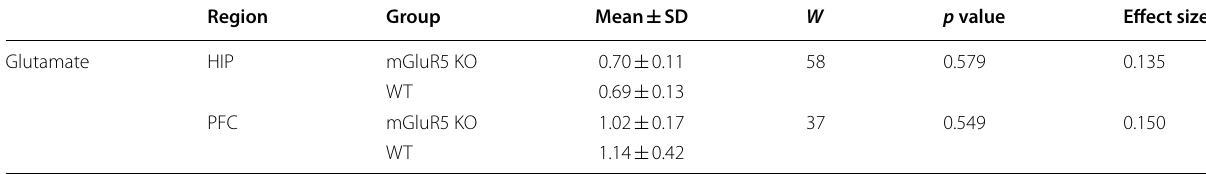
KO knockout, WT wild type, PFC prefrontal cortex, HIP